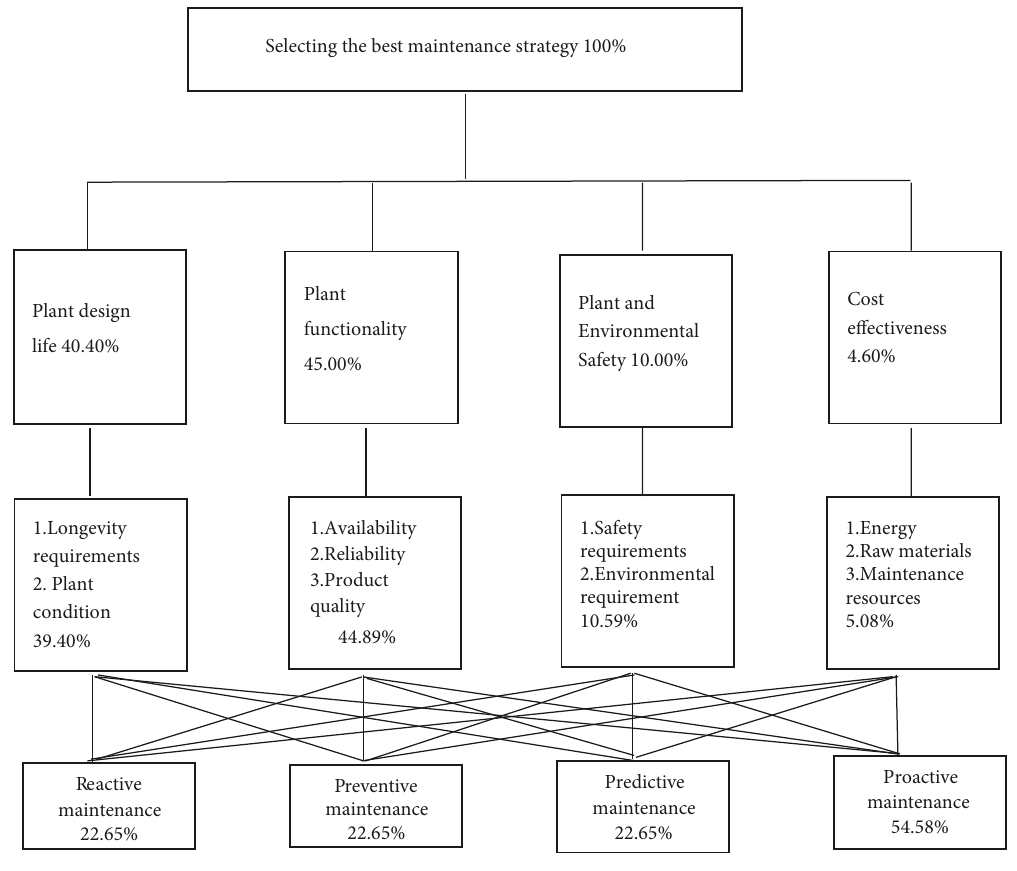
Figure 1: Results of Muinde et al. (2014) [8].